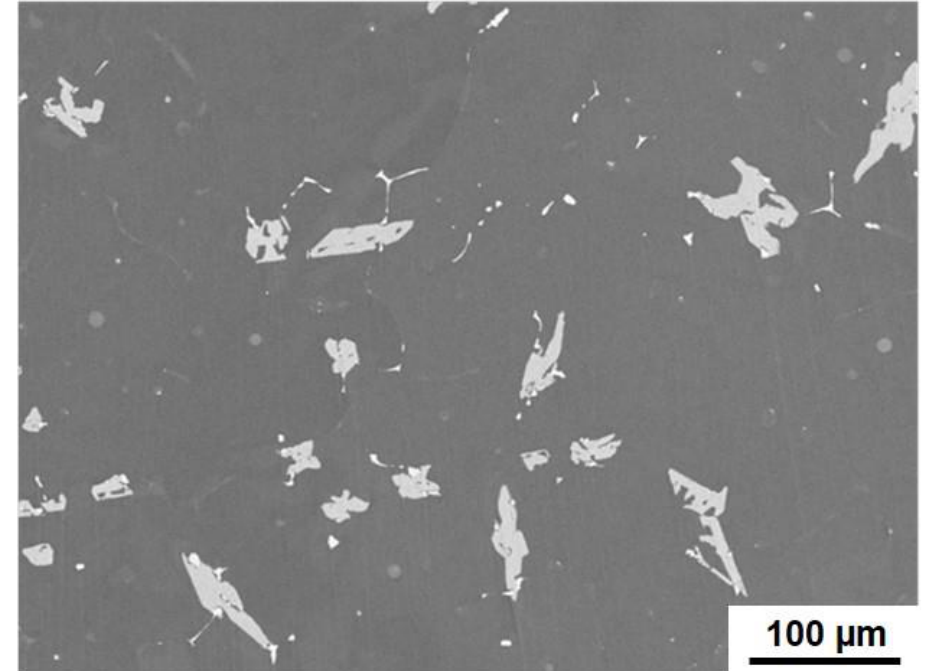
Figure 10. A SEM image of large Al-Cr compounds.